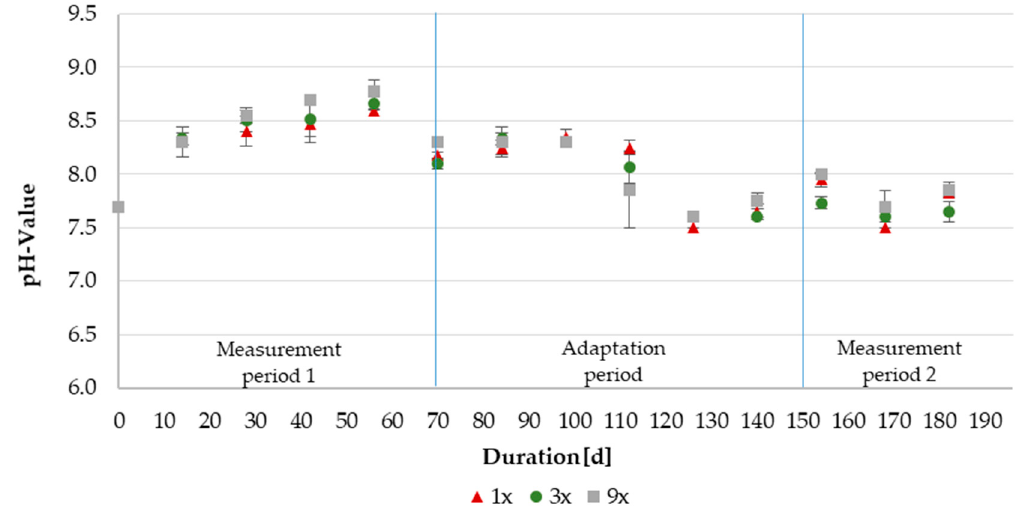
Figure 4. The profile of pH values for the three different feeding strategies during the semi-continuous experiment. The total duration of the operation was 186 days. (1x strategy: n = 28, 3x and 9x strategy: n = 42).